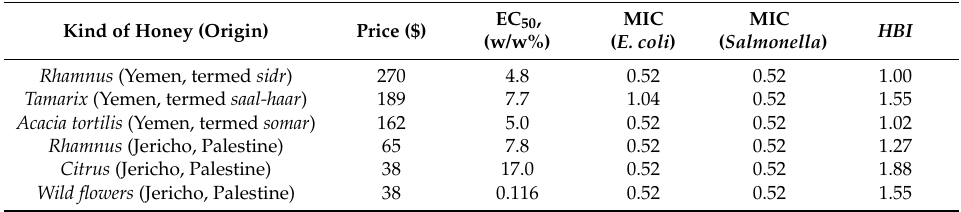
Table 1. Minimum inhibitory concentration (MIC) values of the antimicrobial agents used.